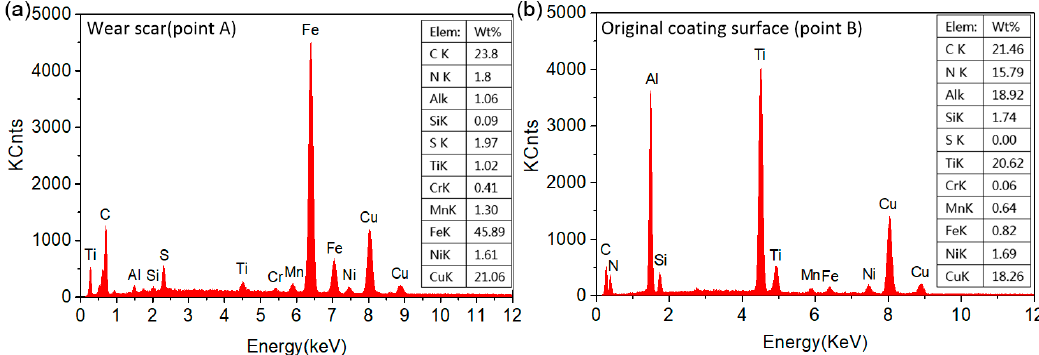
Figure 18. EDX patterns of the TiCN coating on the wear scar and original surface in oil. ( a ) Wear scar; ( b ) Original coating surface.